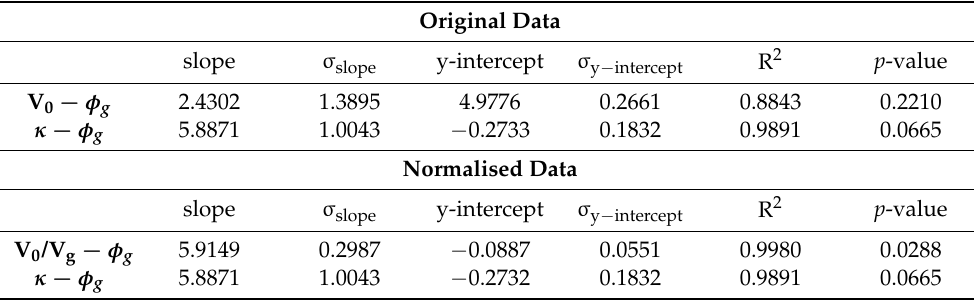
Table 2. Results of linear regression of asymptotic parameters against φ g . The Pearson coefficient of determination (R 2 ) and the p -value associated with hypothesis testing of non-correlation are also